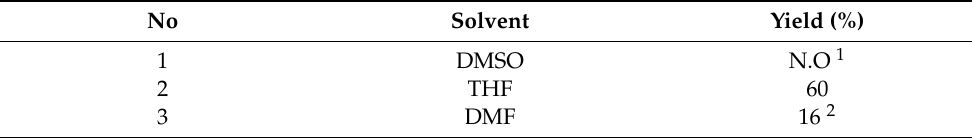
Table 1. Yield of PNHB in aldol reaction in different solvents. No